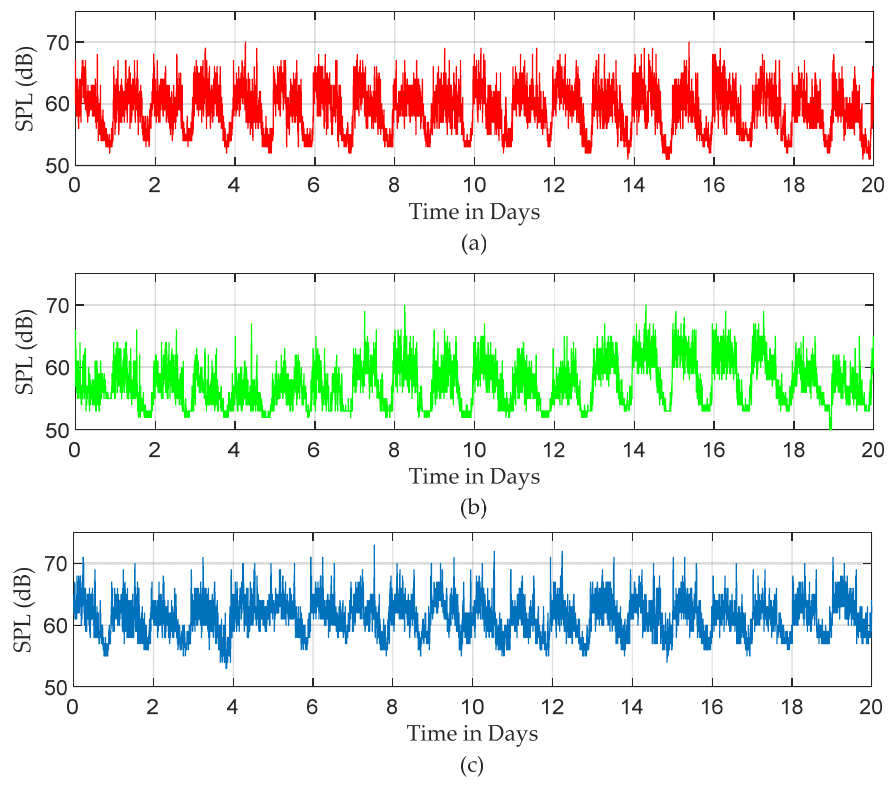
Figure 3. Recorded SPLs in dB over 20 days: ( a ) ICU1, ( b ) ICU2, and ( c ) ICU3.